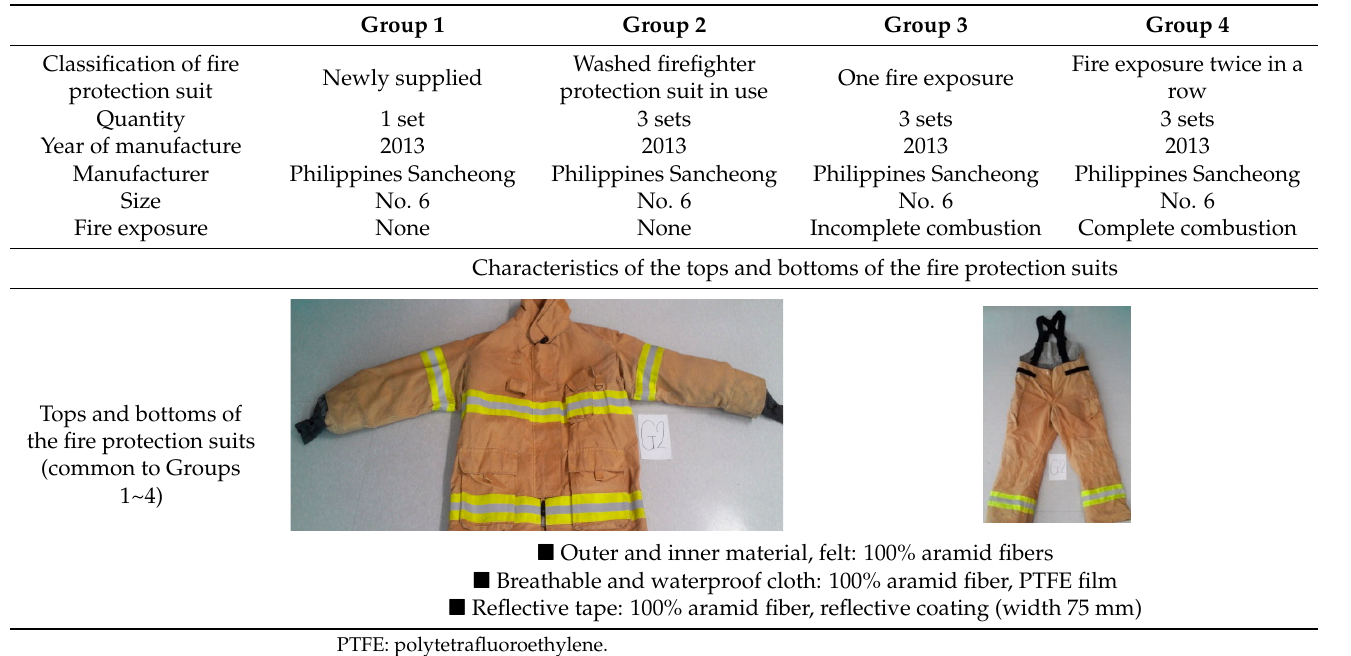
Table 1. Demographic characteristics of simulated fire protection suits by group distribution .